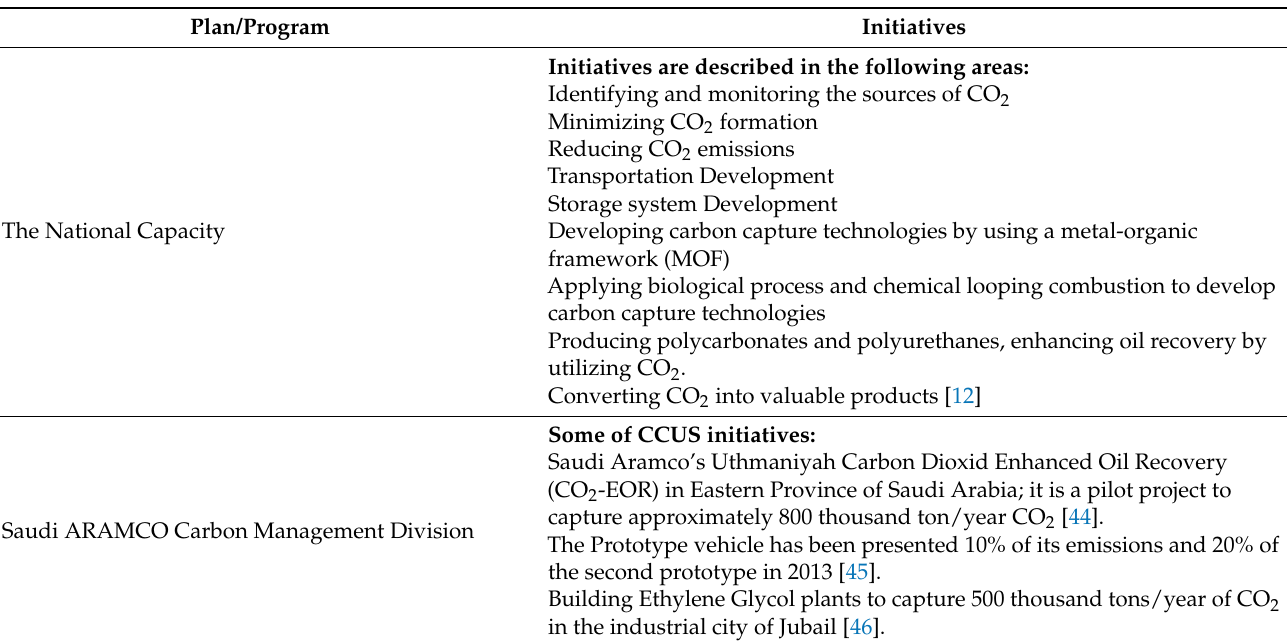
Table 4. GHG emissions reduction initiatives in Saudi